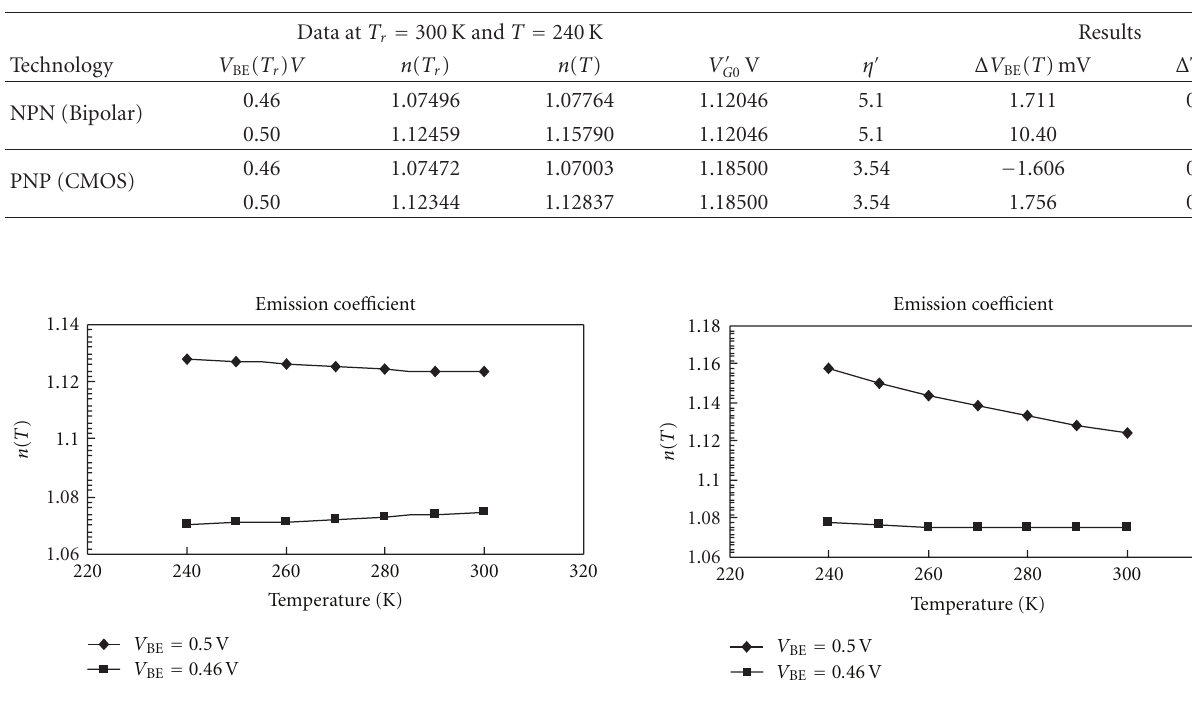
Figure 5: Variation of n ( T ) of standard bipolar MAT01 transistor with η = 3 . 54, V G 0 = 1 . 185 V.